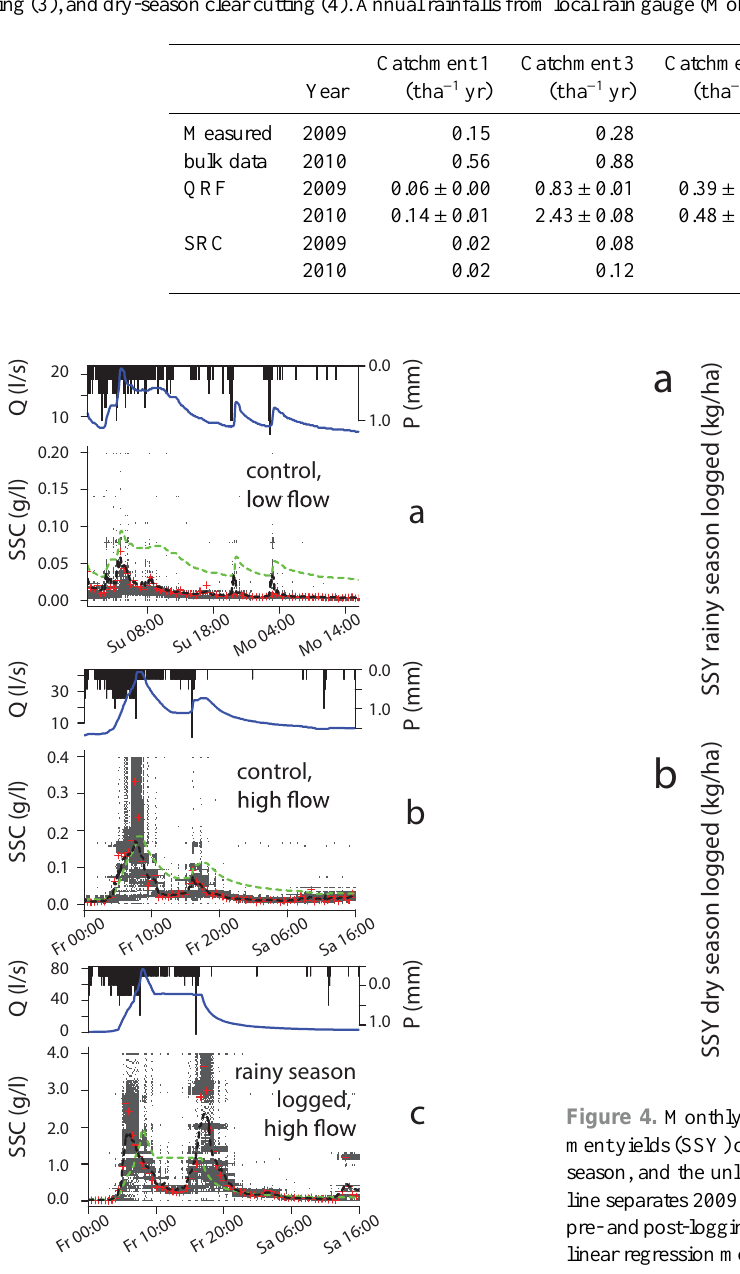
Figure 3. Water discharge and SSC dynamics under unlogged and logged conditions during two rainfall events: (a) 27–29 June 2009, catchment 1; (b–c) 14–15 August 2009, catchments 1 and 3. Den- sity of SSC predictions of the QRF model for each time step en- coded by SSC in coloured histograms: black dashed lines are means of these predictions, red crosses are measured SSC, and green dashed lines are SSC predictions of the SRC. Data are from cali- bration period; that is, periods are covered with SSC samples used for model building (see Fig. 7 for limits to model predictions).